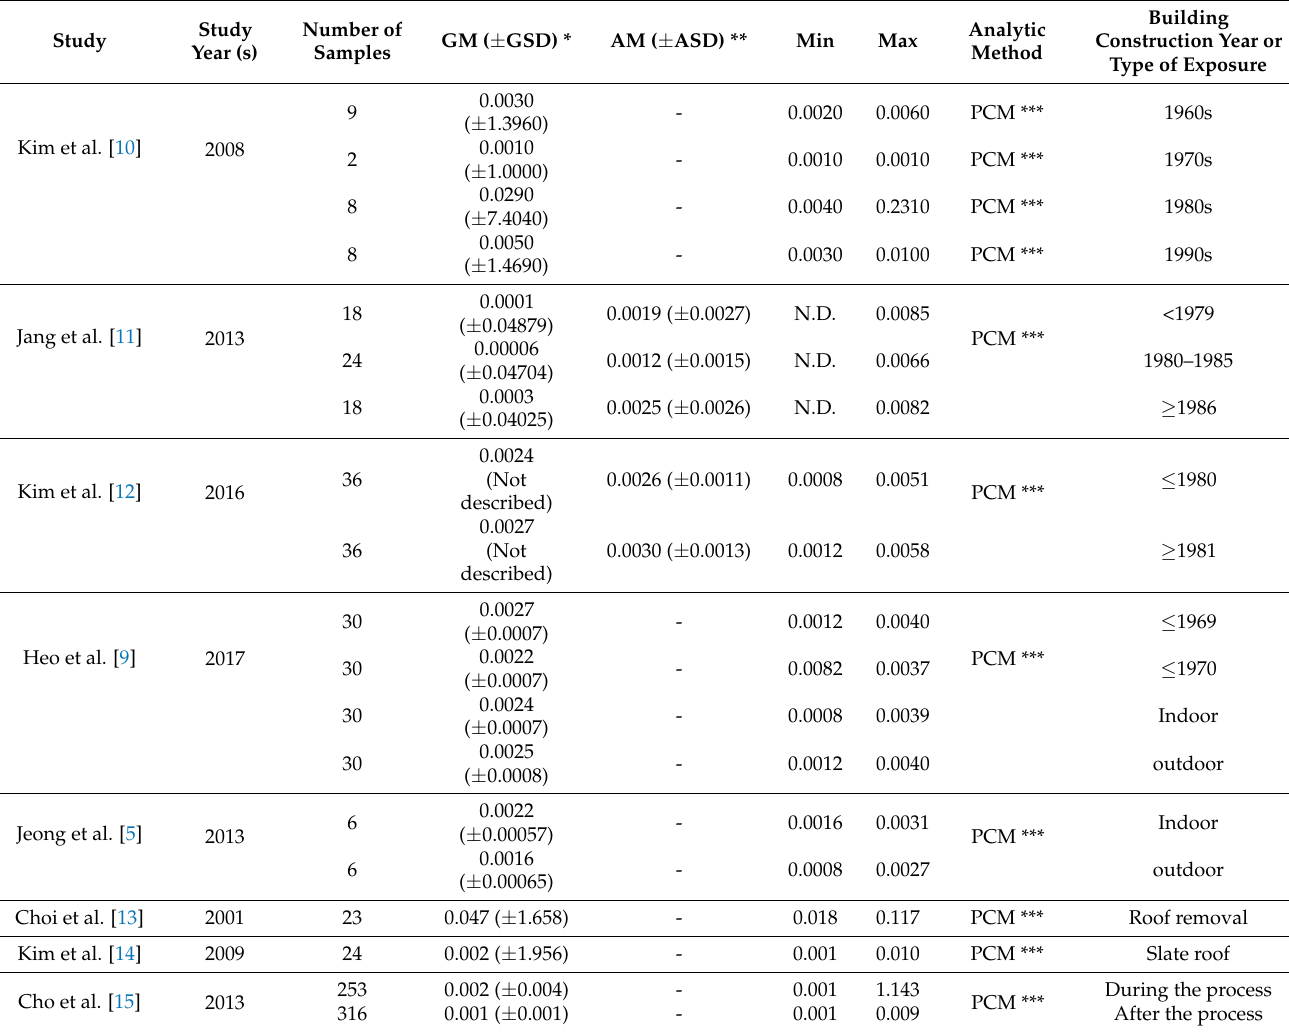
Table 1. Characteristics of Korean studies included in this review where the asbestos concentration was presented as f/cc.